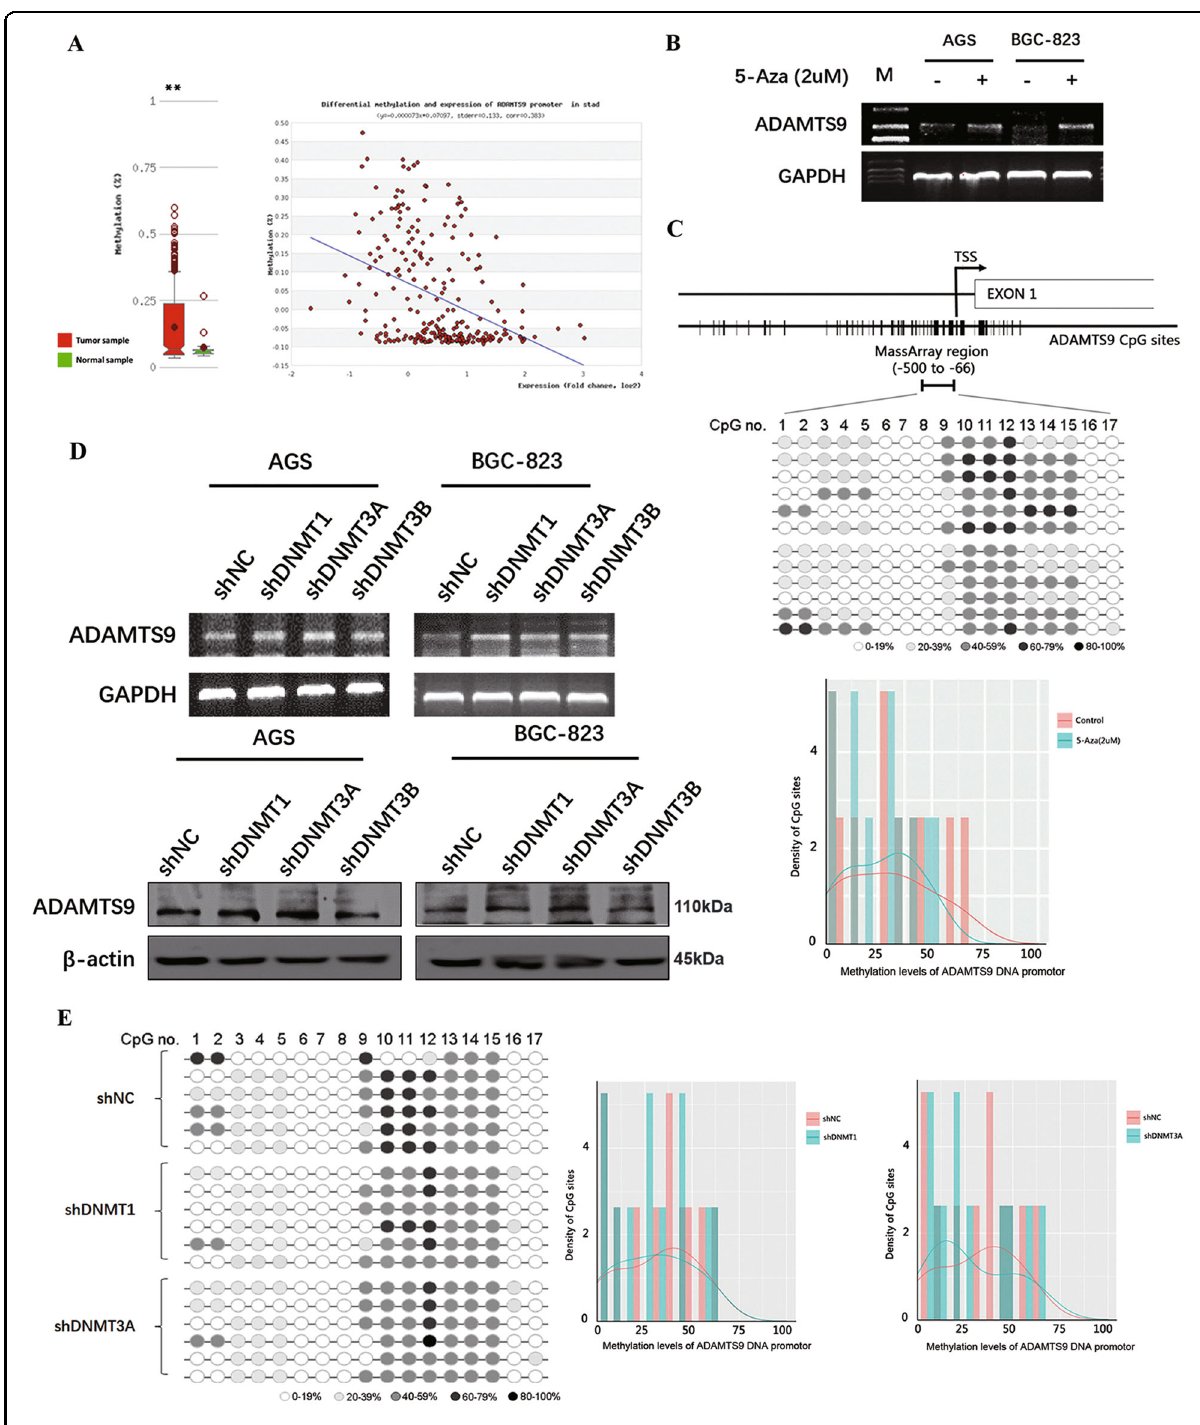
Fig. 4 DNA promoter methylation mainly regulated by the DNMT3A may give rise in the low expression of ADAMTS9 in GC cells. A ADAMTS9 DNA promotor is hypermethylated in the gastric cancer, according to the MethHC database. B The ADAMTS9 expression in AGS and BGC- 823 cells after pharmacological reversal of DNA methylation by 5-Aza was examined by reverse transcriptase PCR. C The MassARRAY analysis spans the promoter region from − 500 to − 66, including 17 CpG islands. The methylation levels of ADAMTS9 DNA promotor after 5-Aza incubation were showed. D The expression of ADAMTS9 in AGS and BGC-823 cells was examined by reverse transcriptase PCR and western blotting method, after transfection with shDNMT1, shDNMT3A, shDNMT3B, or empty plasmid. E The methylation levels of ADAMTS9 DNA promotor after transfection were detected by the MassARRAY